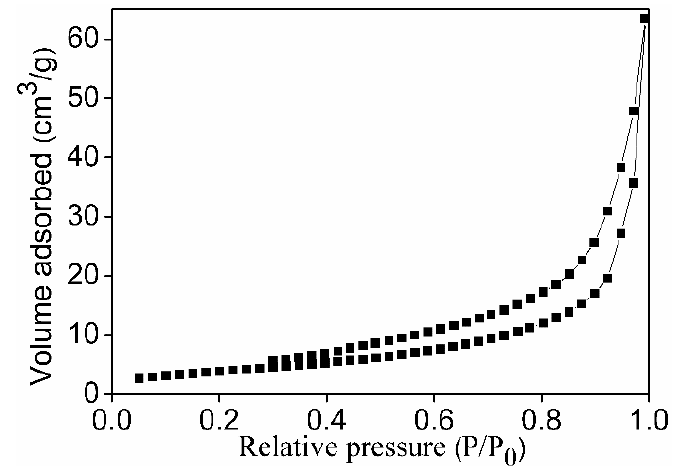
Figure 8. Nitrogen adsorption-desorption isotherm of the MnSb 2 O 6 powders.